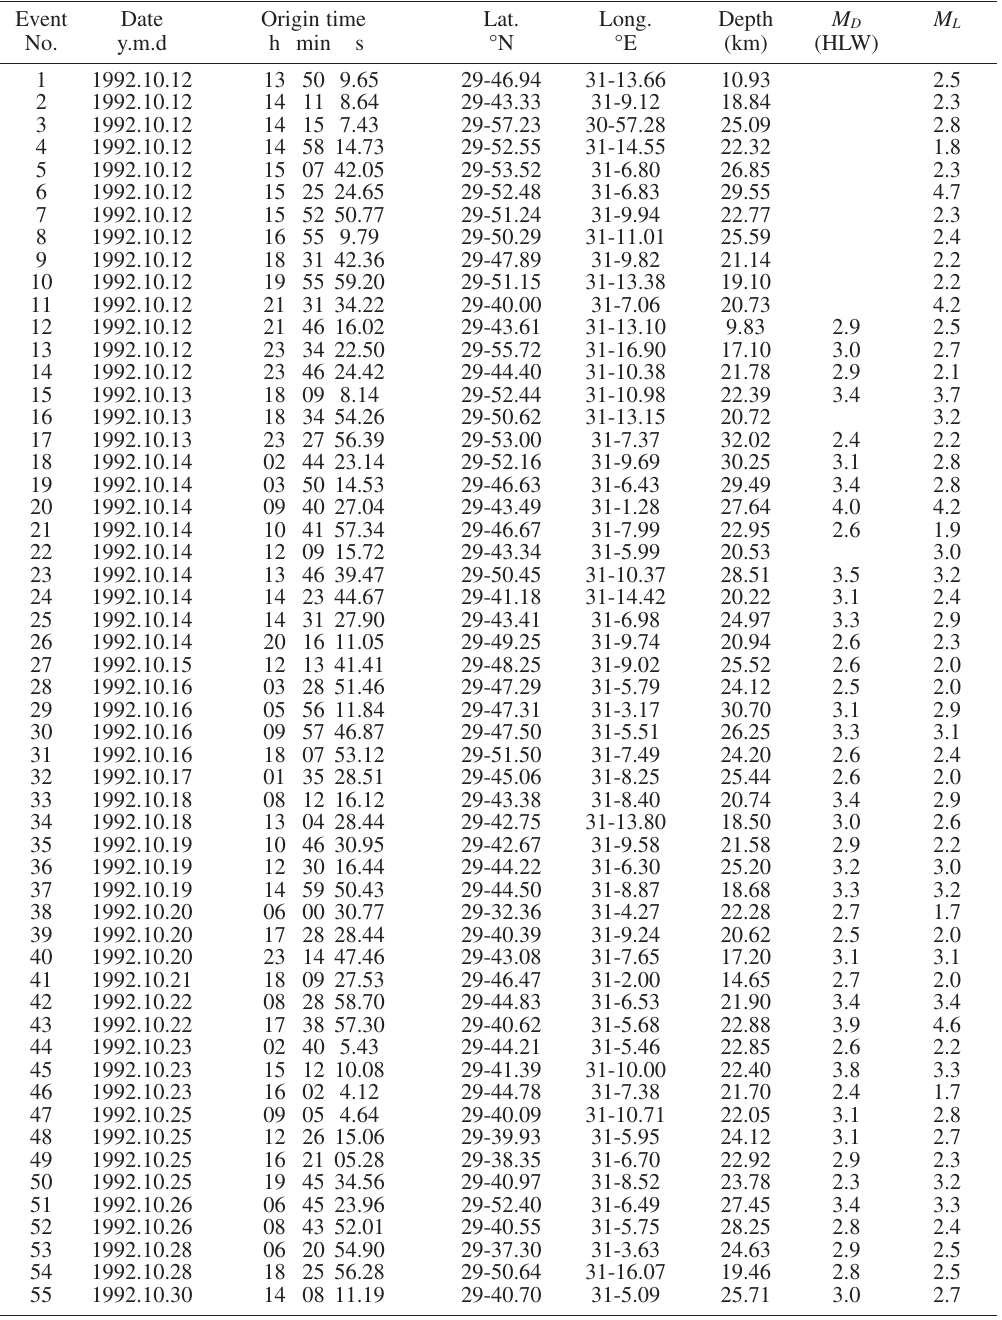
Table I. List of earthquakes used in this